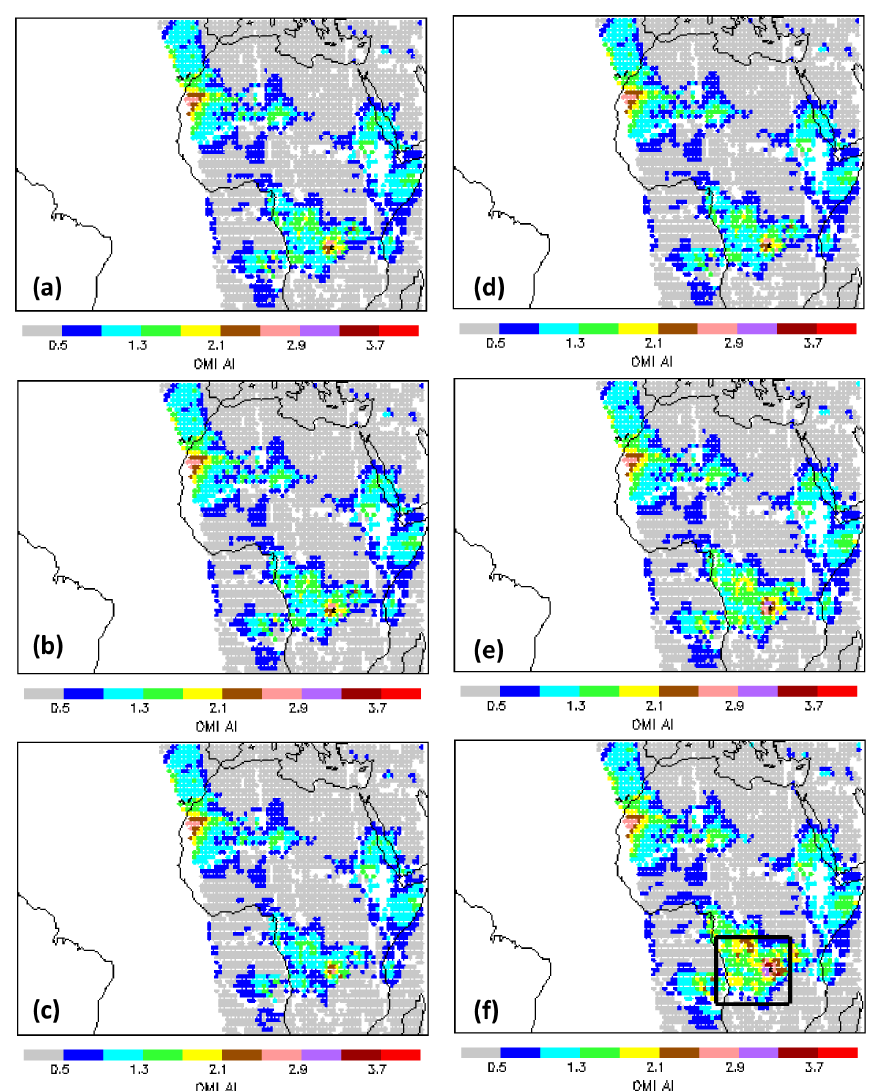
Figure 6. Spatial distributions of simulated AI at 12:00Z on 28 July 2007 using NAAPS reanalysis data, with single-scattering albedos of smoke aerosol at 354 and 388nm taken to be the following: (a) 0.84 and 0.84; (b) 0.85 and 0.85; (c) 0.86 and 0.86; (d) 0.85 and 0.85; (e) 0.85 and 0.855; (f) 0.85 and